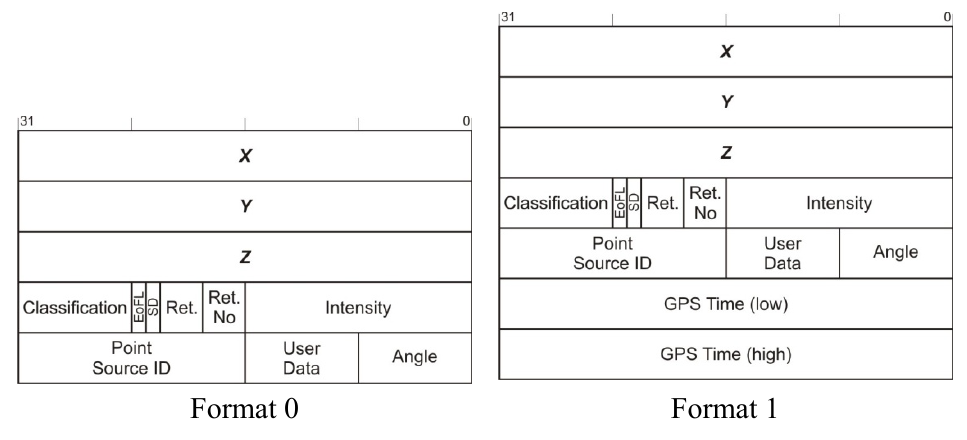
Figure 1. LIDAR point data record structures defined by LAS format version